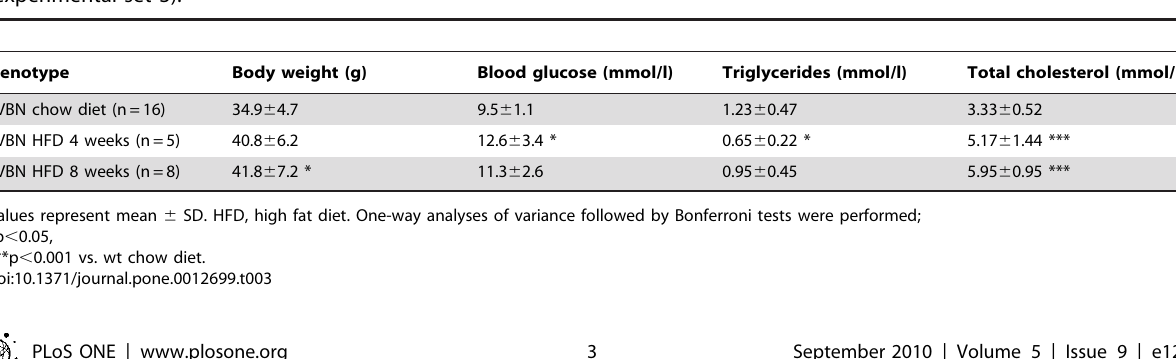
Table 3. Body weight, blood glucose, triglycerides and total cholesterol in FVBN mice, fed normal chow or HFD for 4 or 8 weeks (experimental set